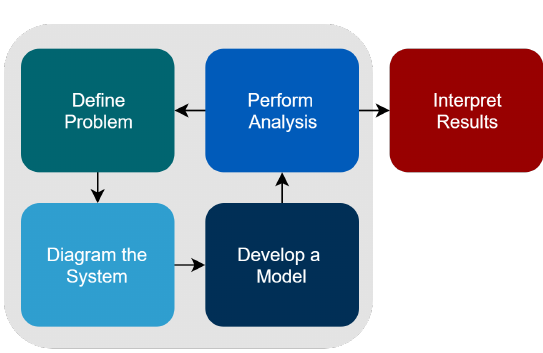
Fig. 1. Process diagrams for engineering case